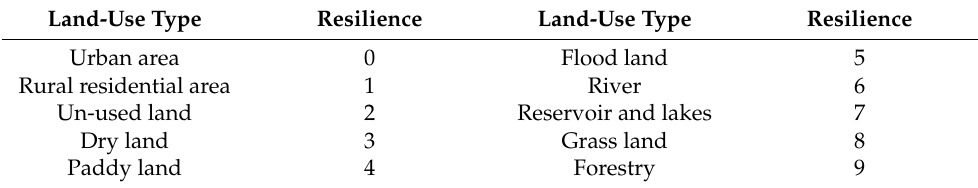
Table 3. Ecological resilience of different land-use